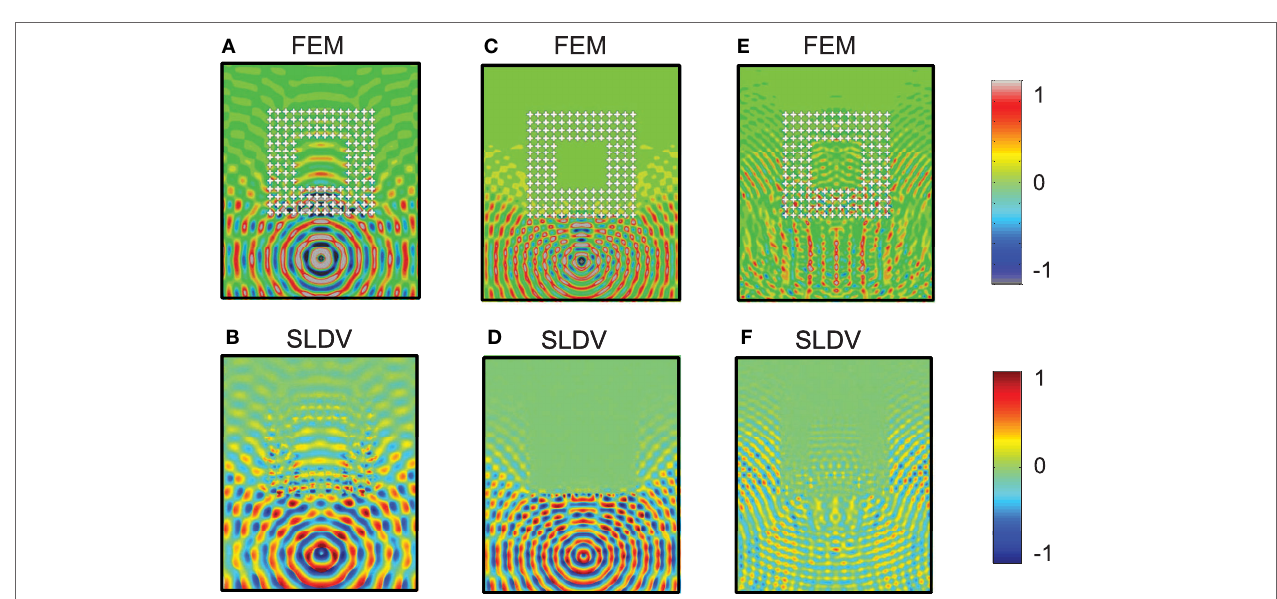
FigUre 10 | Computed and experimental out-of-plane displacement, respectively, for excitations below (a,B) , inside (c,D) , and above (e,F) the BGs. Numerical results are computed by means of ABAQUS, and measurements are performed by means of a PSV 400 3D SLDV by